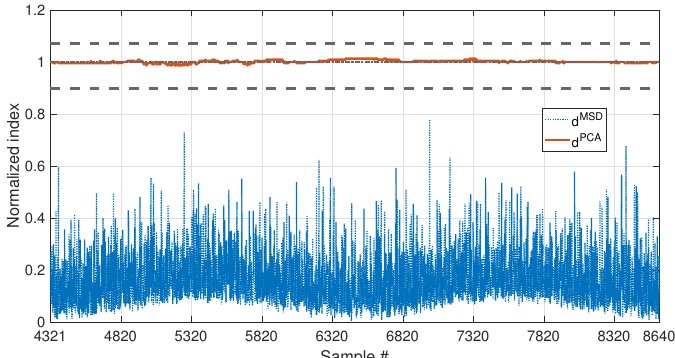
Figure 7. Comparison between d MSD (blue dotted line) and d PCA (red solid line), with b = 4320, considering a long-term temperature